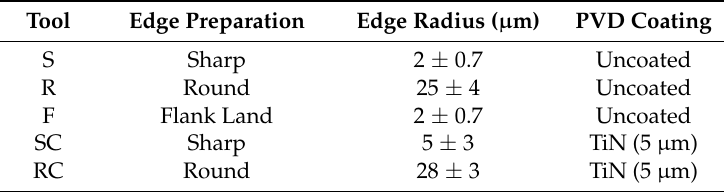
Table 5. Cutting tool specifications in machining AISI 4340 steel [39].